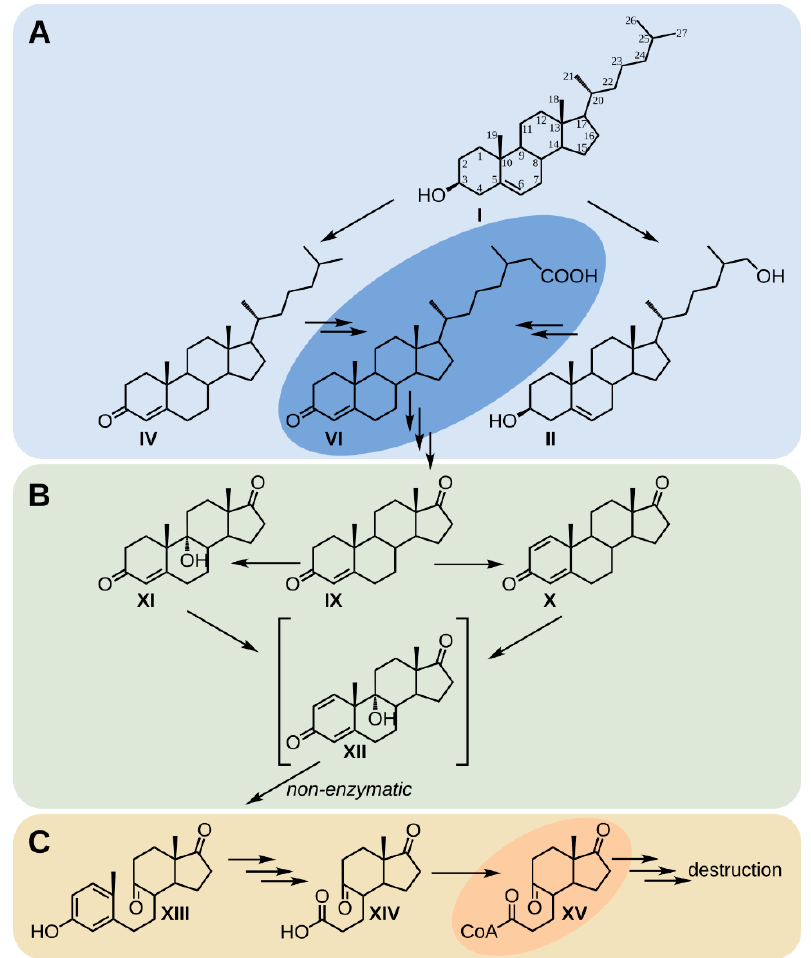
Figure 8. Principal scheme of cholesterol catabolism by mesophilic actinobacteria. ( A ) Dehydro- genation and isomerization of 3 β -ol-5-ene to 3-keto-4-ene moiety in the steroid core A-ring and deg- radation of the sterol side chain to C19-steroid. ( B ) Steroid core B-ring opening via 9 α -hydroxylation and 1(2)-dehydrogenation. ( C ) Steroid core degradation via the 9(10)- seco pathway. I, cholesterol; II, cholest-5-ene-3 β ,26-diol (26-Hydroxycholesterol); IV, cholest-4-en-3-one; VI, 3-oxo-cholest-4-en-26- oic acid, a KstR effector [32]; IX, androst-4-ene-3,17-dione (AD); X, androsta-1,4-diene-3,17-dione (ADD); XI, 9 α -hydroxyandrost-4-ene-3,17-dione (9 α -hydroxy-AD); XII, 9 α -hydroxyandrosta-1,4- diene-3,17-dione (unsTable 9 α -hydroxy-ADD); XIII, 3 β -hydroxy-9,10- seco -androsta-1,3,5(10)-triene- 9,17-dione (3-HSA); XIV, 9,17-dioxo-1,2,3,4,10,19-hexanorandrostan-5-oic acid (DOHNAA) or 3a α - H-4 α -(3 ′ -propanoate)-7a β -methylhexahydro-1,5-indadione (HIP); XV, 9,17-dioxo-1,2,3,4,10,19-hex- anorandrostan-5-oyl-CoA (HIP-CoA), a KstR2 effector Known microbial sterol degradation begins with C26-hydroxylation of the sterol al- kyl side chain and/or modification of the A ring of the steroid core by converting 3 β -hy- droxy-5-ene- into a 3-oxo-4-ene-structure [1,42]. These two processes can occur simulta- neously. Indeed, independent and simultaneous conversion of cholesterol into C26-hy- droxylated 3 β -hydroxy-5-ene- and 3-oxo-4-ene- corresponding derivatives has been clar- ified previously in the case of S. hirsuta [15]. As shown in this study, cholesterol is a poor growth substrate for S. hirsuta. The strain transforms cholesterol to form corresponding derivatives with the preserved side chain, such as cholest-4-en-3-one or 26-hydroxylated steroids. Much higher strain growth and cholesterol conversion/degradation rates were observed when a rich medium was used instead of a mineral one.